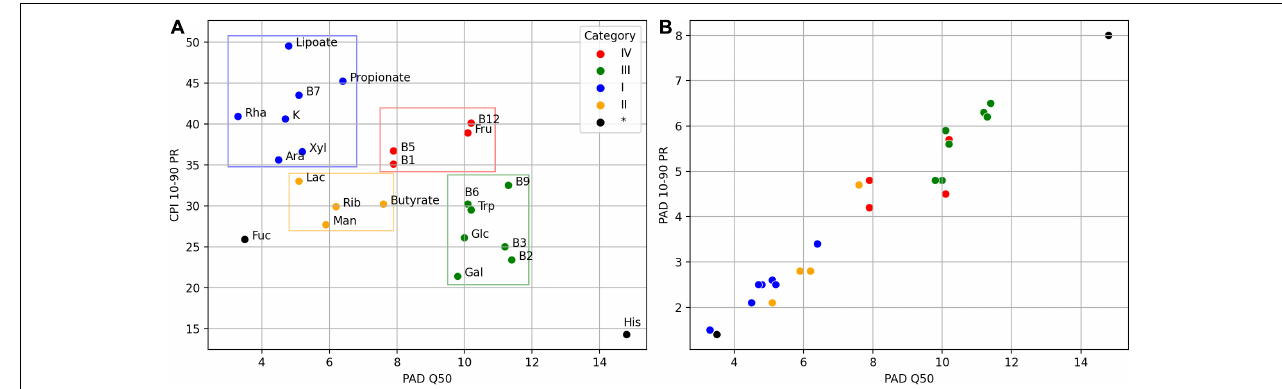
FIGURE 7 | Mutual dependence of the CPI and PAD values obtained for the AGP and UKT datasets. (A) Dependence between median PAD (PAD Q50) and variation of CPI (CPI 10–90 percentile range). A total 22 metabolic phenotypes are clustered into four categories, with two phenotypes remained unclassified. (B) Dependence between median PAD (PAD Q50) and variation of PAD (PAD 10–90 percentile